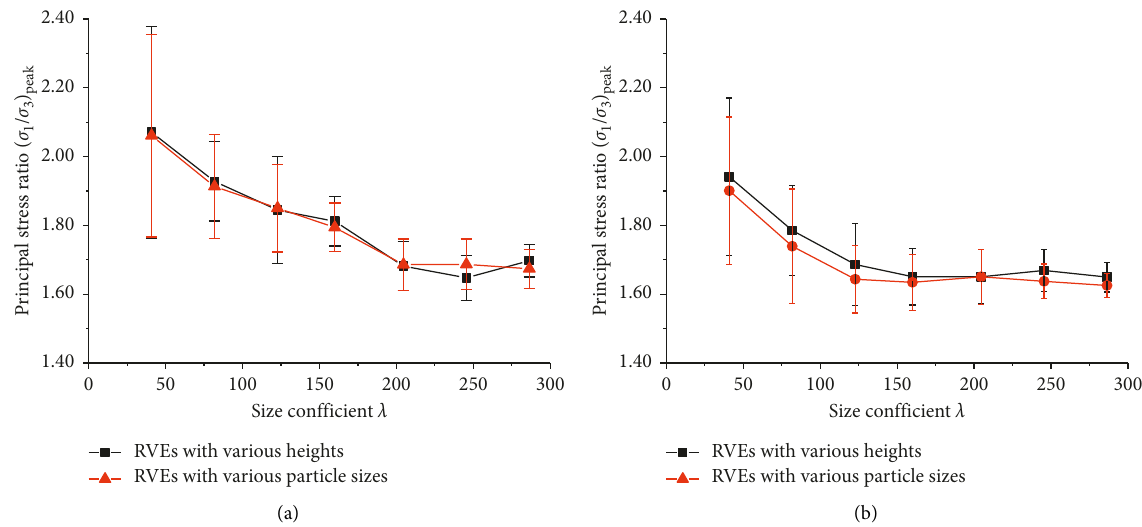
Figure 6: Peak principal stress ratio-size coefficient relationship of RVEs with various heights and particle sizes. (a) At 0g gravity. (b) At 5g gravity.